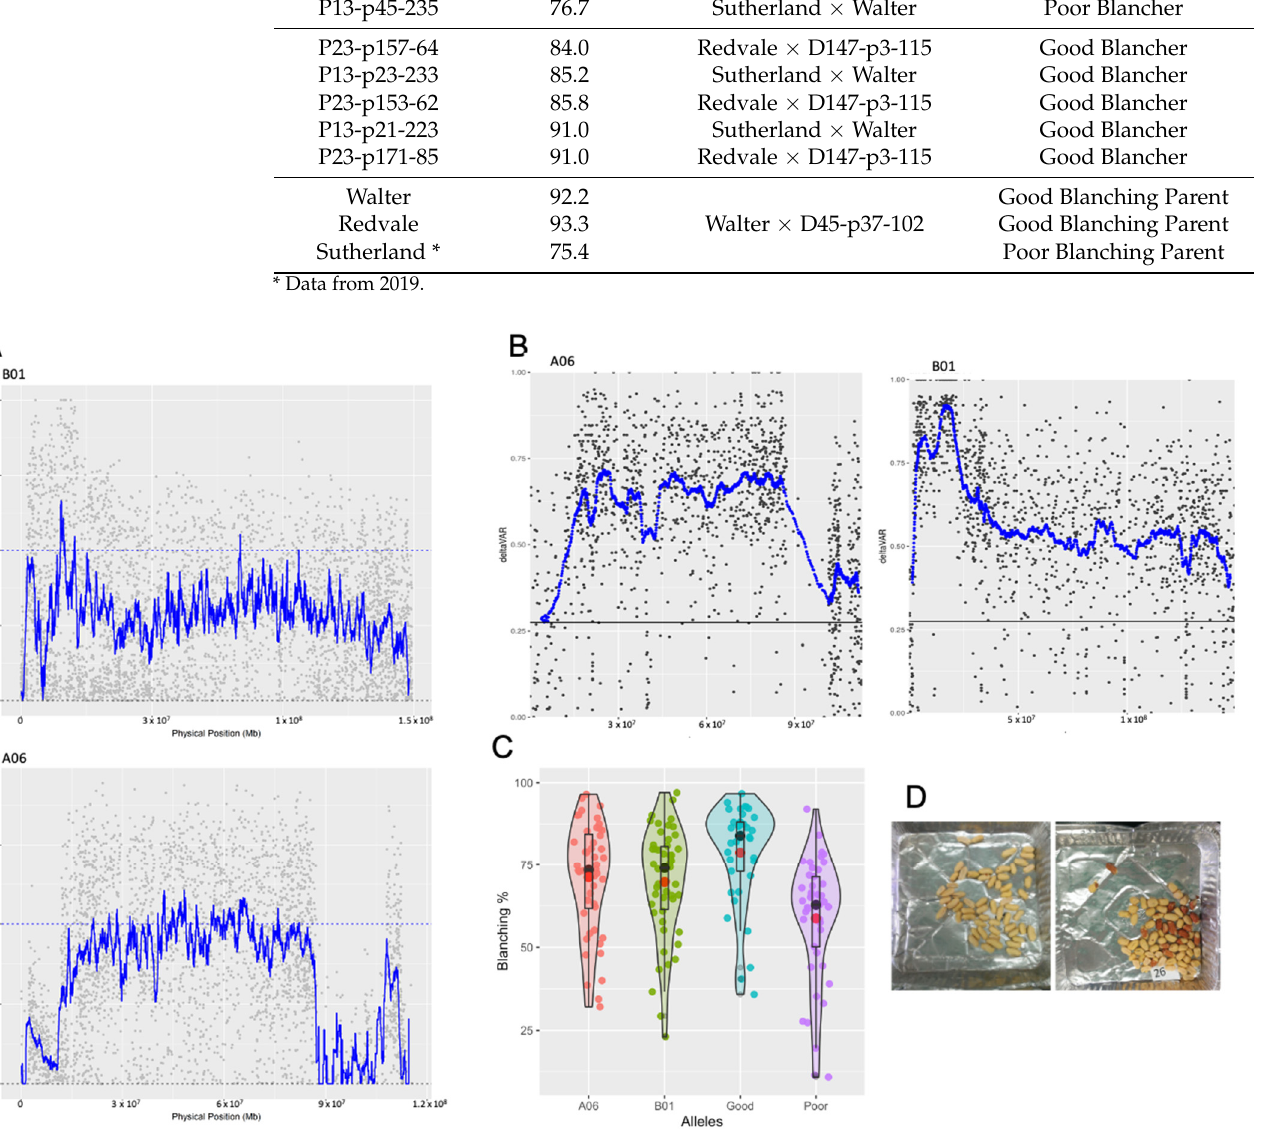
Figure 1. ( A ) Initial QTL-seq using parental sequence to identify SNPs for use in analyzing bulk sequence. Delta SNP—the difference in allele frequency between the good blanching bulk and the poor blanching bulk—is 0 to 1, where 1 is good blanching allele. ( B ) The same QTLs identified with Khufu de novo from bulk sequence. Because allele parentage is not discerned, delta SNP is set from 0 (equal frequency between bulks) to 1 (complete segregation between bulks). ( C ) Validation of markers in an independent RIL population. Violin/Jitter/Box plots show the blanching% of RILs with the high blanching allele at A06 only, B11 only, both A06 and B11, and both poor (low blanching) alleles. Black dots show median values, and red dots are the mean. Selecting for either marker alone is significant compared to selecting for both poor alleles, and selecting for the good blanching allele at both loci provides the highest blanching percentage and skews the distribution towards 100%. ( D ) Representative pictures of a good blanching sample (left) and a poor blanching sample (right).